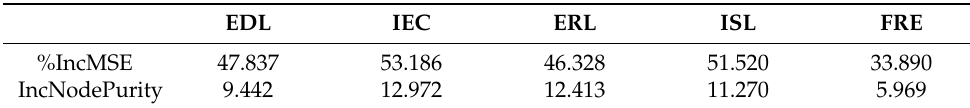
Figure 7. Scatter diagram of IncMSE and IncNodePurity. Table 5. Analysis results of IncMSE and